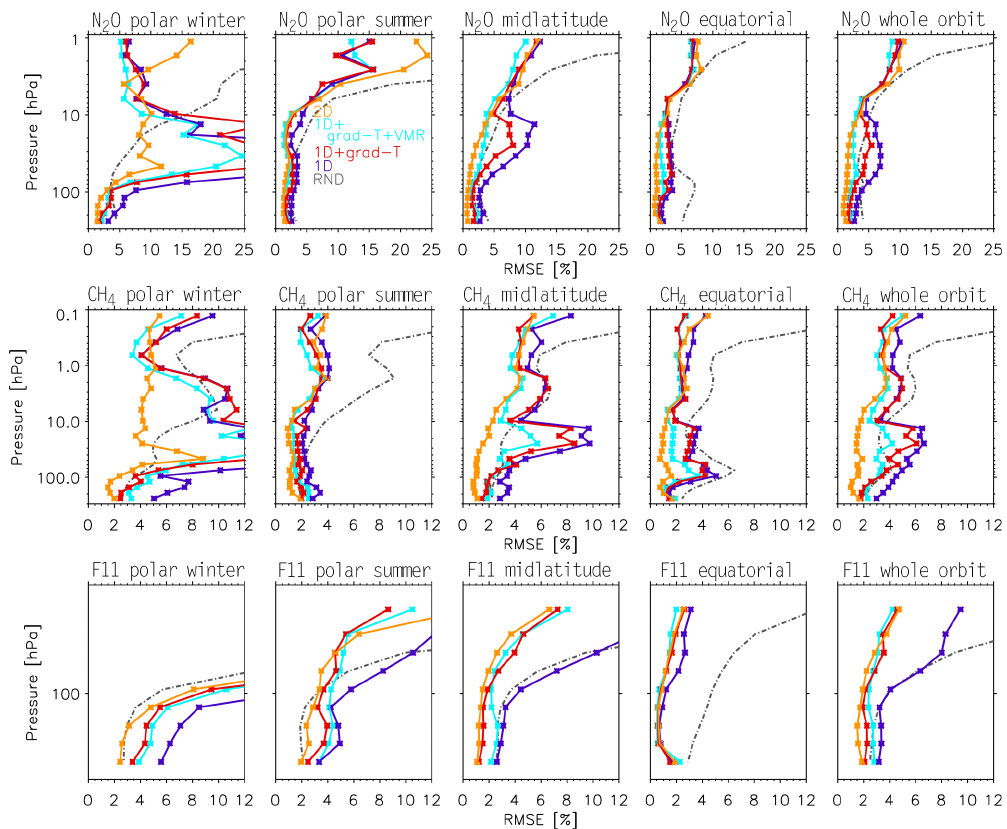
Figure 7. From top to bottom: RMSE calculations for N 2 O, CH 4 and CFC-11 in polar winter, polar summer, midlatitude, equatorial and whole orbit scenarios. The colour code is the same as in Fig.